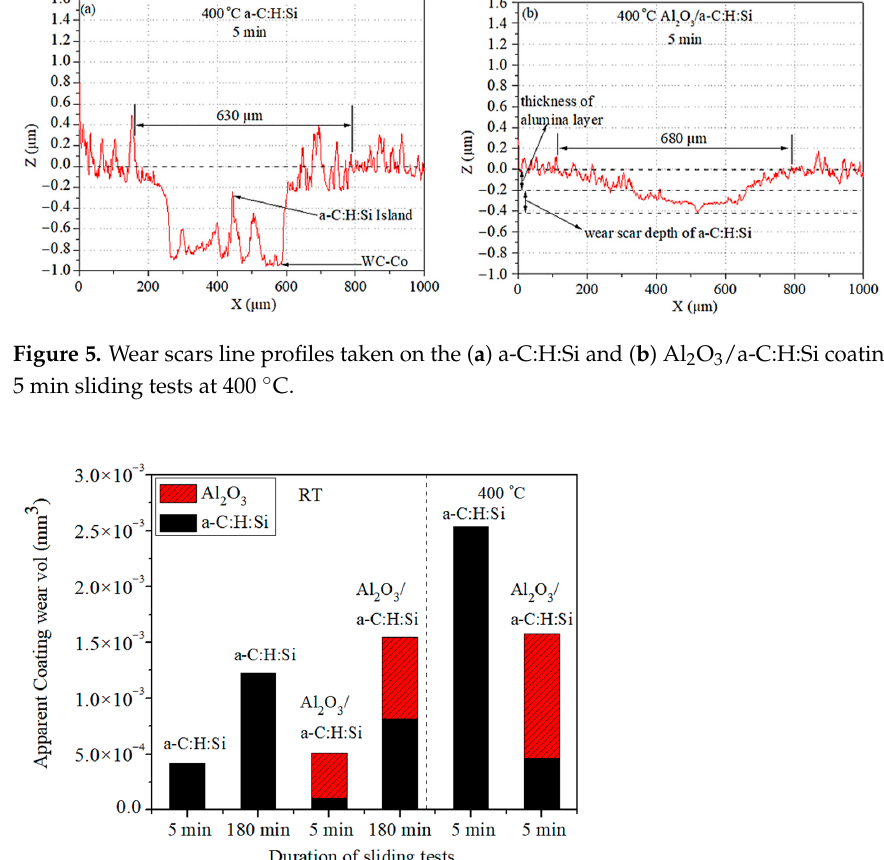
Figure 4. Wear scars line profiles taken on the ( a , b ) a-C:H:Si and ( c , d ) Al 2 O 3 /a-C:H:Si coatings after the ( a , c ) 5 and ( b , d ) 180 min tests at RT.